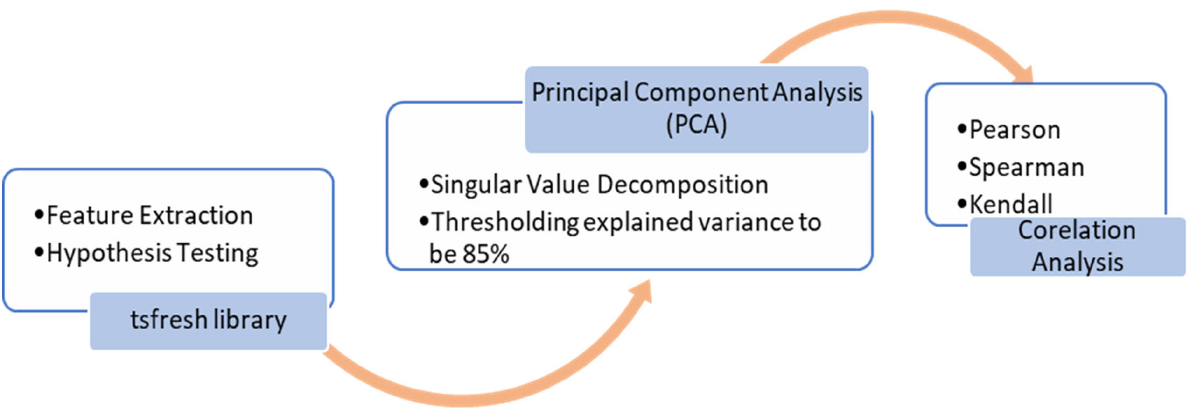
Figure 3. Stages of feature extraction and feature selection. The tsfresh library calculates and shortlists the hundreds of time-series features, PCA is applied to reduce the feature dimension; to select well-distinguishable features, correlation coefficients are calculated using the three methods.